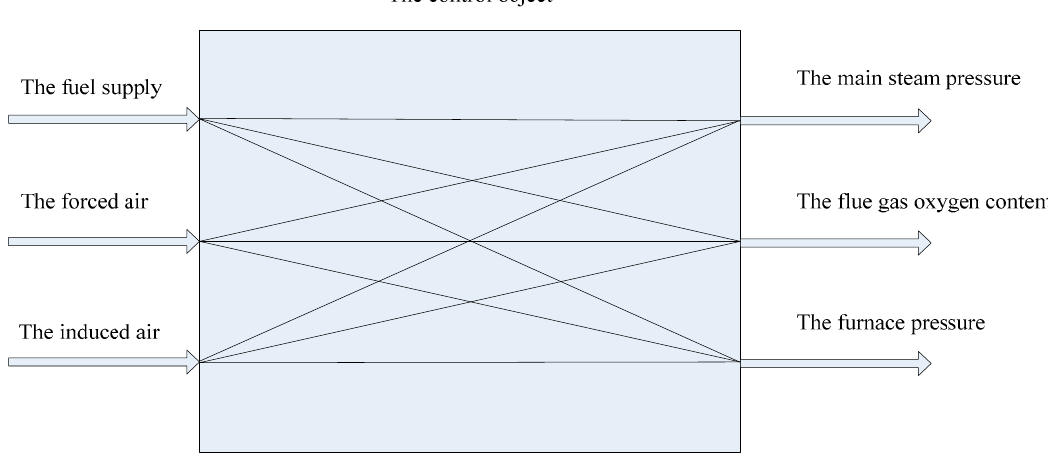
Figure 2. The chart of boiler combustion control system.